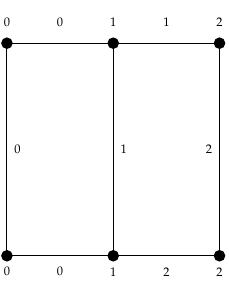
Figure 6. 3-TEMC labeling of L 3